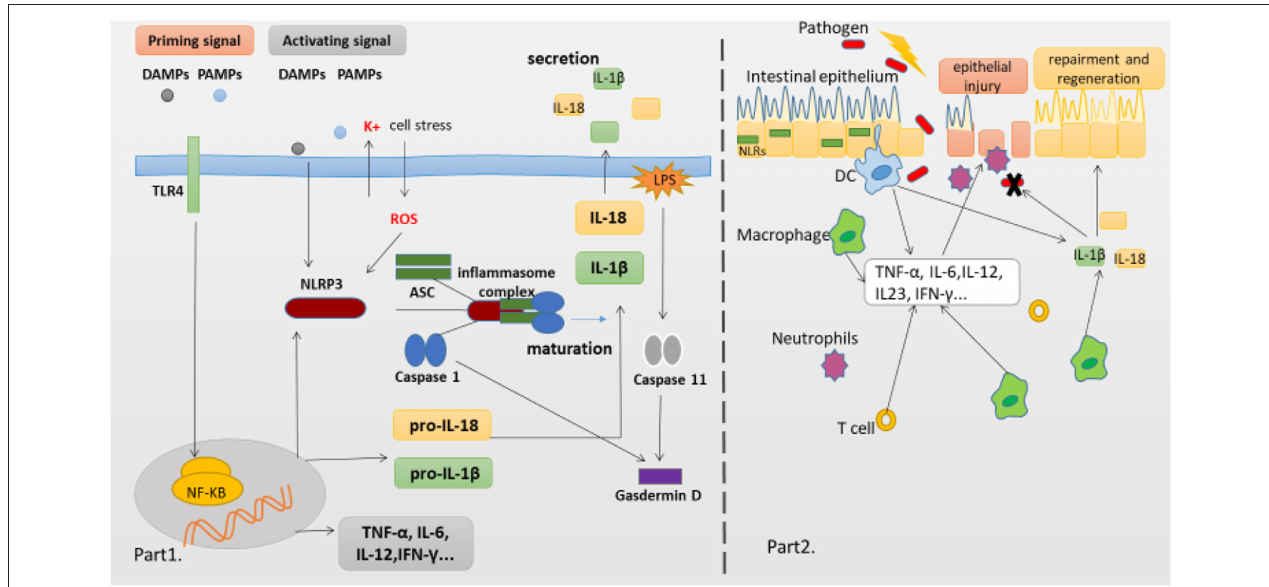
FIGURE 1 | NLRP3 Inflammasome complex and pathology of the IBD. (Part 1) The production of proinflammatory cytokines IL-1 β and IL-18 is a two-step process. NF- κ B activation can rapidly prime the expressions of pro-IL-1 β and pro-IL-18, which are then cleaved into the mature IL-1 β and IL-18 by caspase-1 in the Inflammasome. The second signal can directly activate inflammasome assembly. And cleavage of gasdermin D by caspase-11 and caspase-1 is essential for pyroptosis of innate immune cells and endothelial cells harboring LPS-tainted cytoplasm. (Part 2) The intestinal epithelial barrier protects underlying mucosal tissues from commensal bacteria present in the gut. But in susceptible hosts, the epithelial barrier is compromised allowing commensal bacteria to invade lamina propria and mucosa. Infiltrated bacteria interact with macrophages, Dendritic cells(DC) and neutrophils via innate recognition receptors such as NLRs. Activation of NLRs induces the production of proinflammatory cytokines which further recruit immune cells to the infected tissue accelerating inflammatory